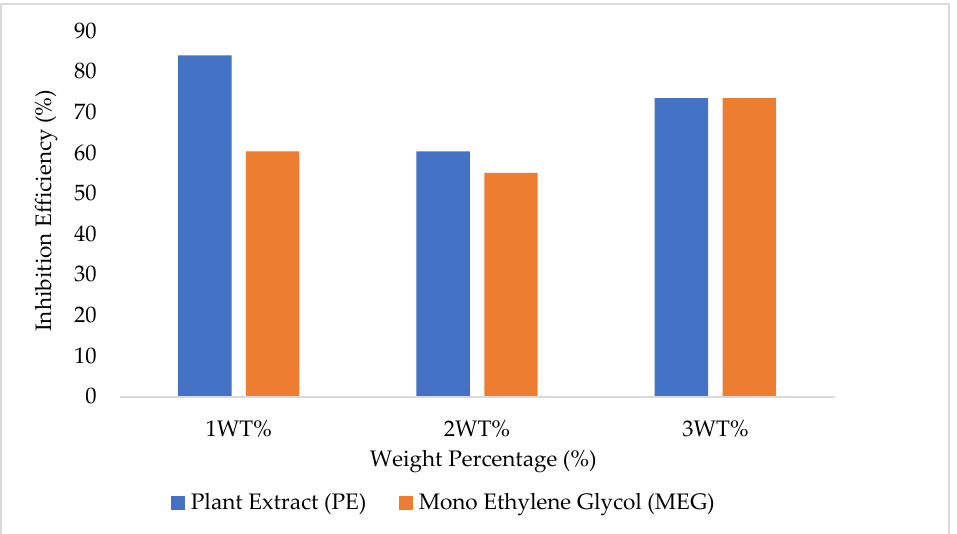
Figure 10. Inhibition Efficiency versus Weight percentage for Plant Extract (PE) and Mono Ethylene Glycol (MEG).